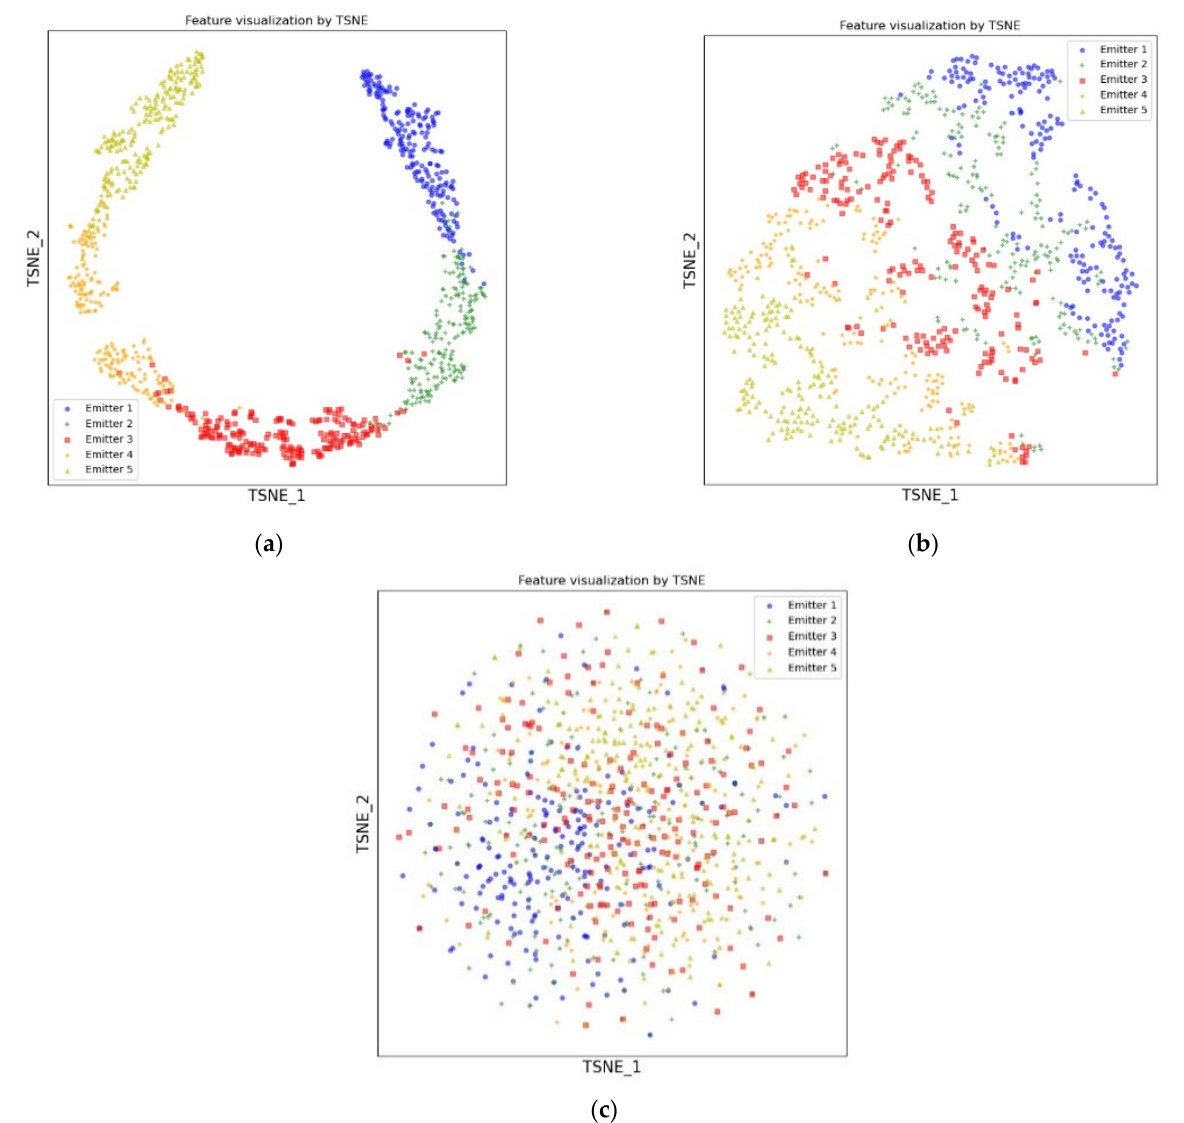
Figure 9. T ‐ SNE visualizations. ( a ) The output of Encoder with image data augmentation and signal truncation; ( b ) The output of Encoder with only image data augmentation; ( c ) The output of Encoder with no augmentation.